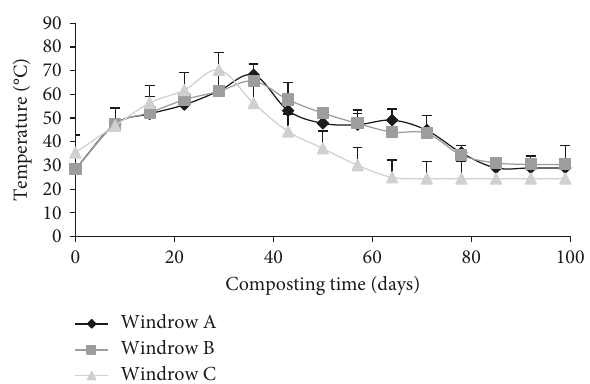
Figure 1: The windrows’ temperature profiles during the com- posting process.